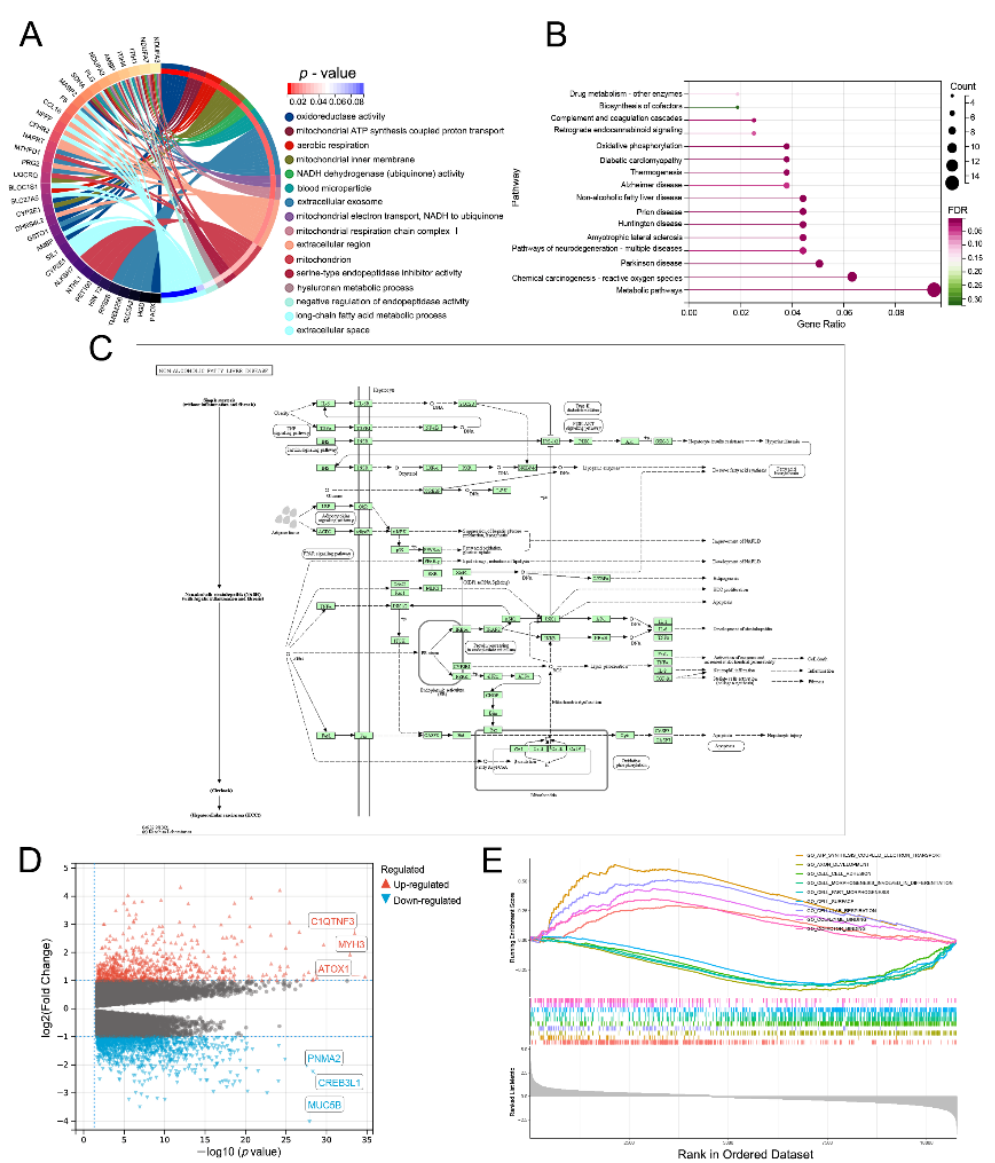
Figure 4. The signaling pathways and biological processes of lnc-RAB11B-AS1 ( A ) GO analysis. ( B ) Pathway enrichment analysis based on KEGG. ( C ) KEGG pathway: NAFAD. ( D ) Volcano plot of DEGs. Blue and red dots represent the significantly down-regulated and up-regulated DEGs, respectively. ( E ) Ten significantly enriched pathways based on GSEA.